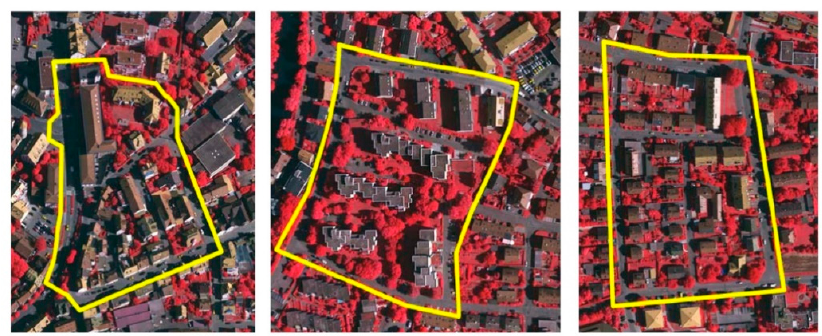
Figure 5. Test sites of scene Vaihingen. From left to right: areas 1, 2, and 3 [34].